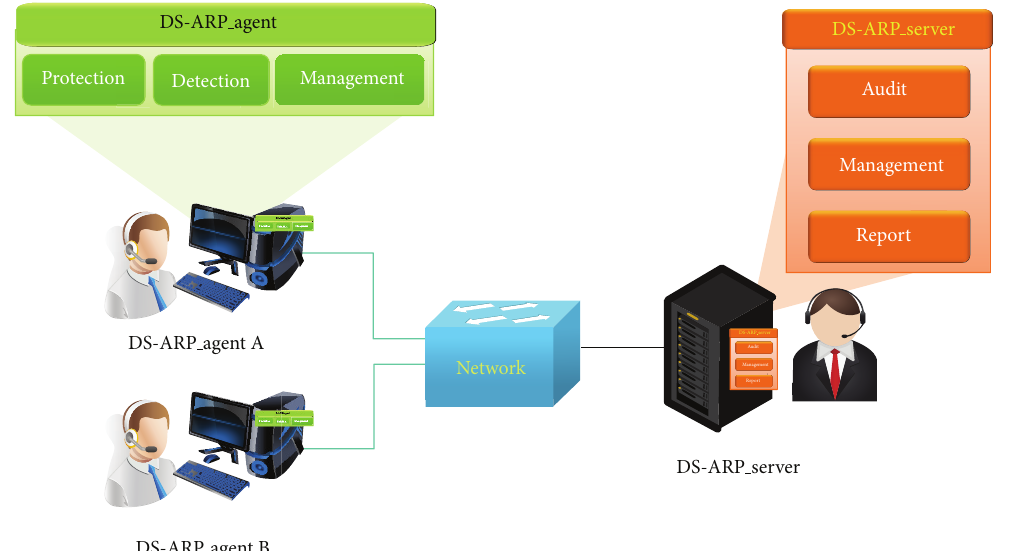
Figure 2: Overall architecture of the DS-ARP scheme.